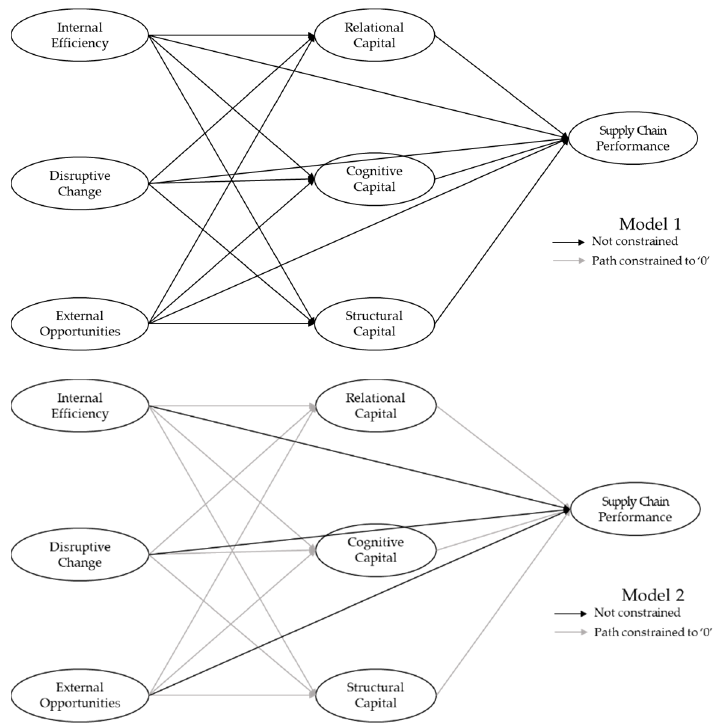
Figure 3. Alternative models to verify the mediating effect (Model 1 and Model 2).